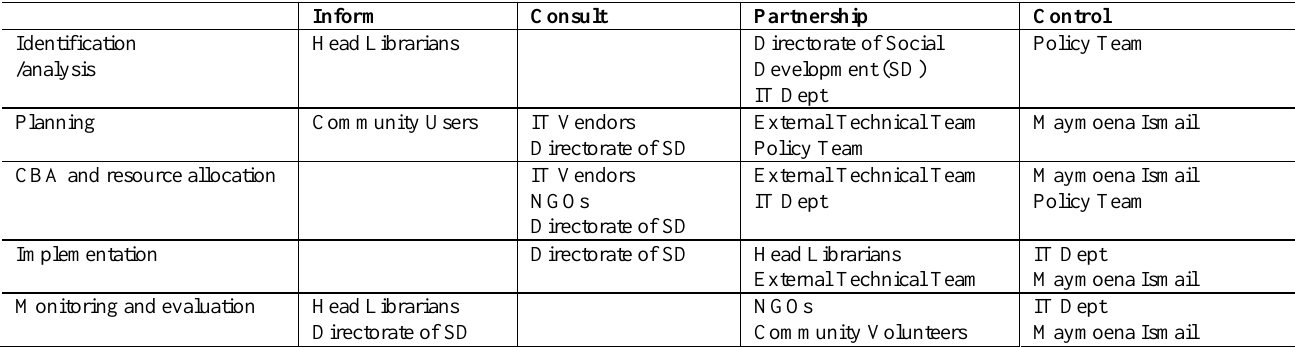
Table 2: Stakeholder management